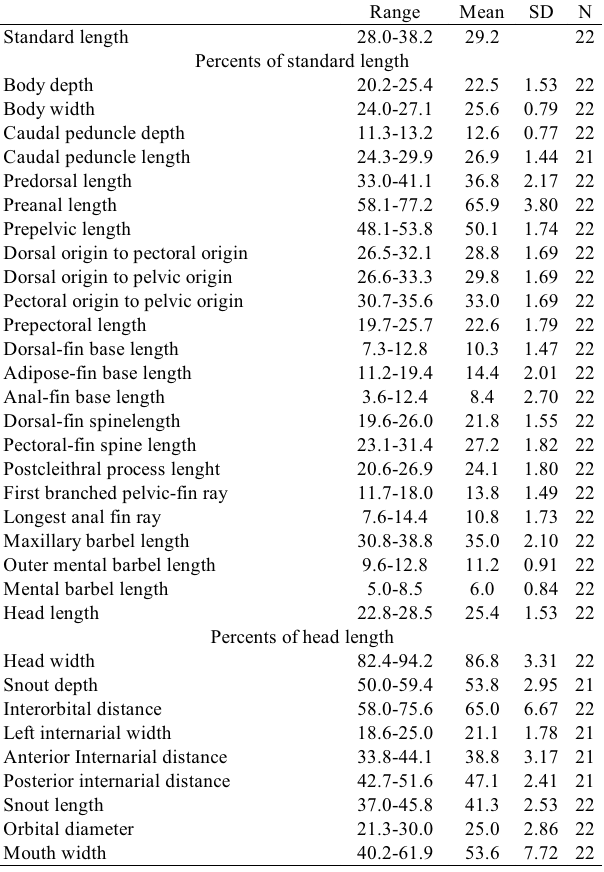
Table 8. Morphometric data for Tatia gyrina . SD = standard